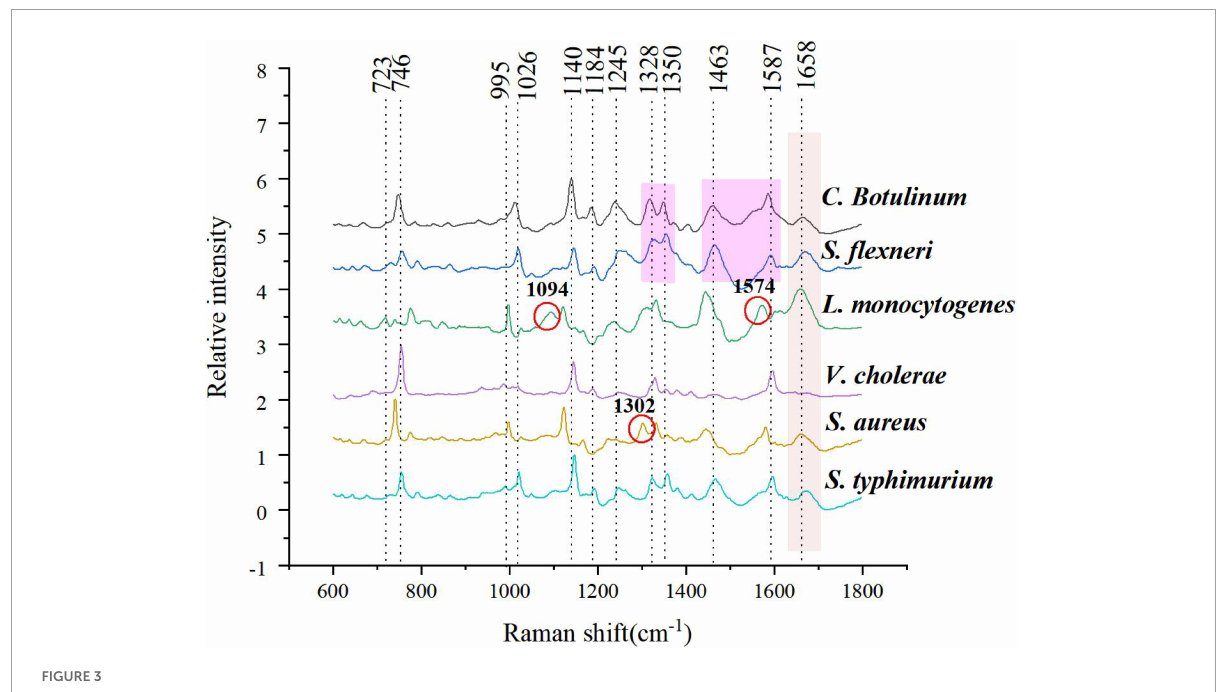
FIGURE3 Mean normalized spectra of six bacterial species.